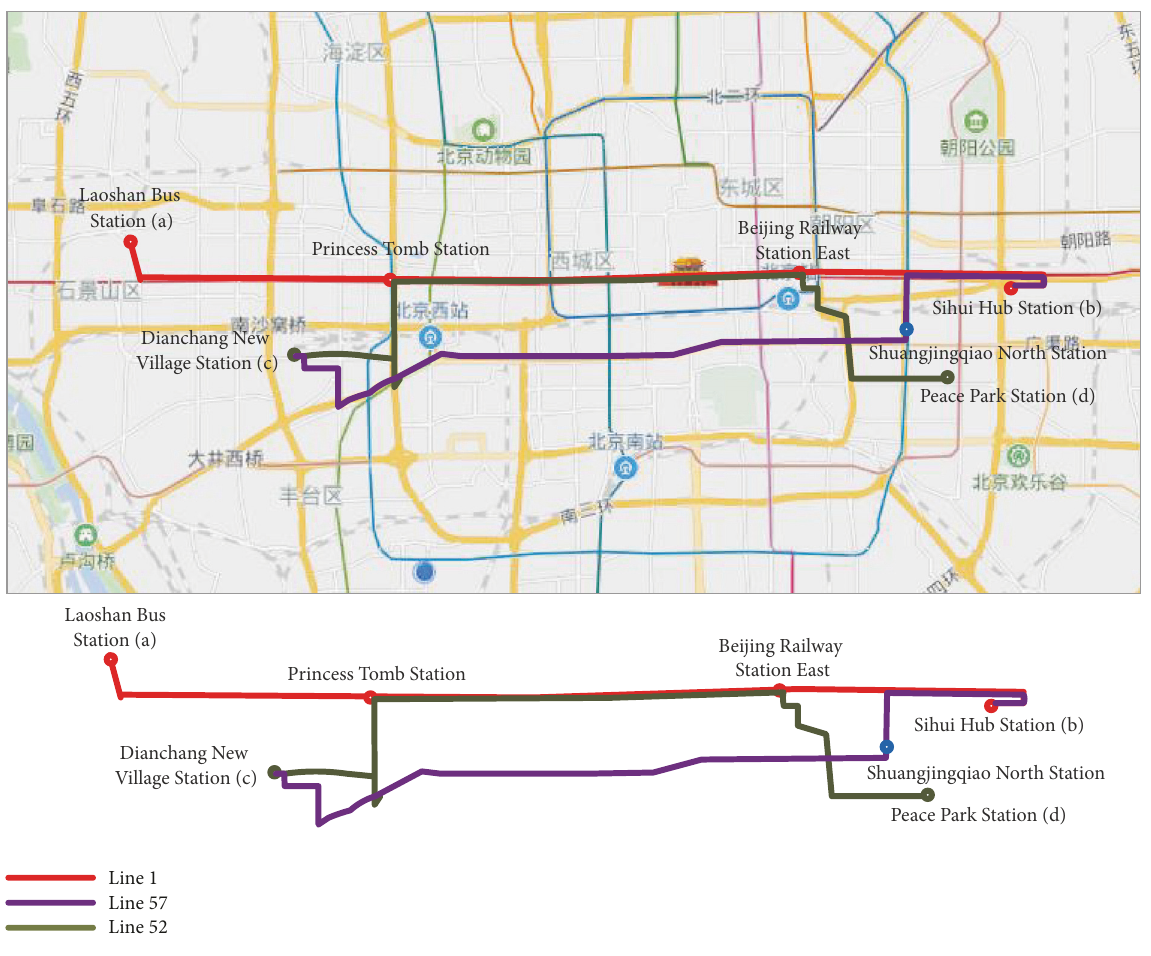
Figure 5: Bus routes of Line1, Line 57, and Line